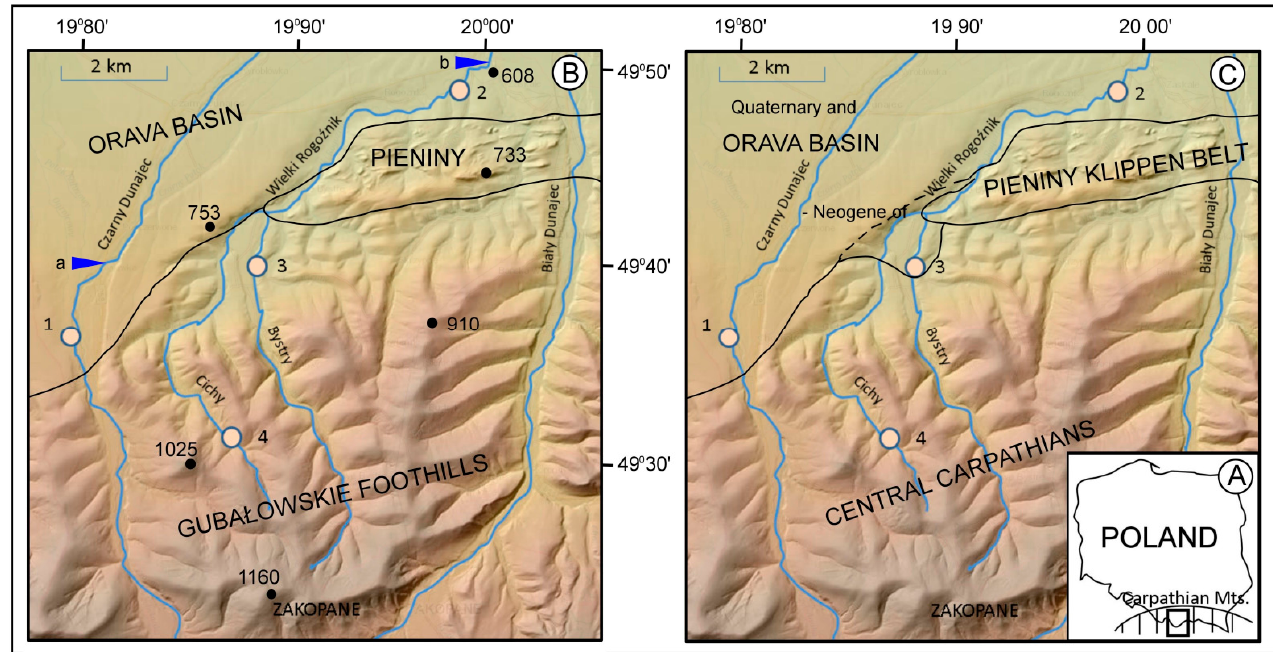
Figure 1. Location of the study sites in the Carpathians ( A ) and in morphology ( B ) and geology ( C